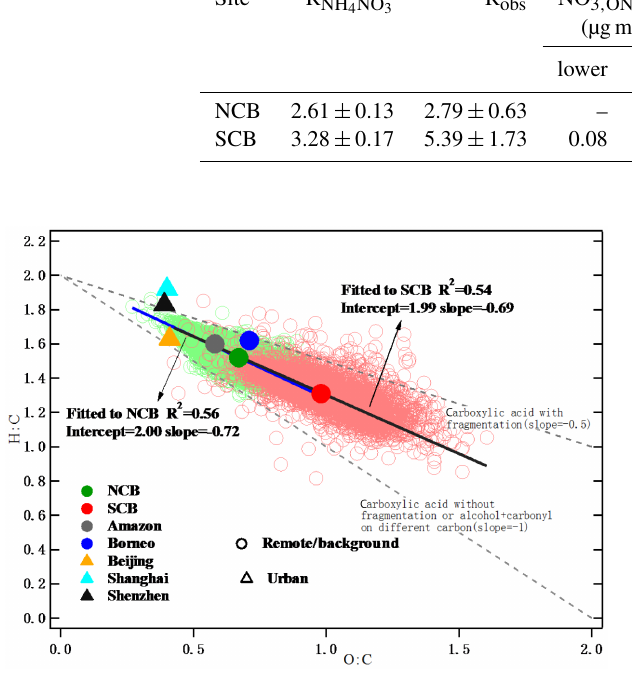
Figure 5. Van Krevelen diagrams (H / C versus O / C) of OA at NCB (light green) and SCB (light red). The campaign-average O / C and H / C ratios of remote/background and urban sites in the literature are also